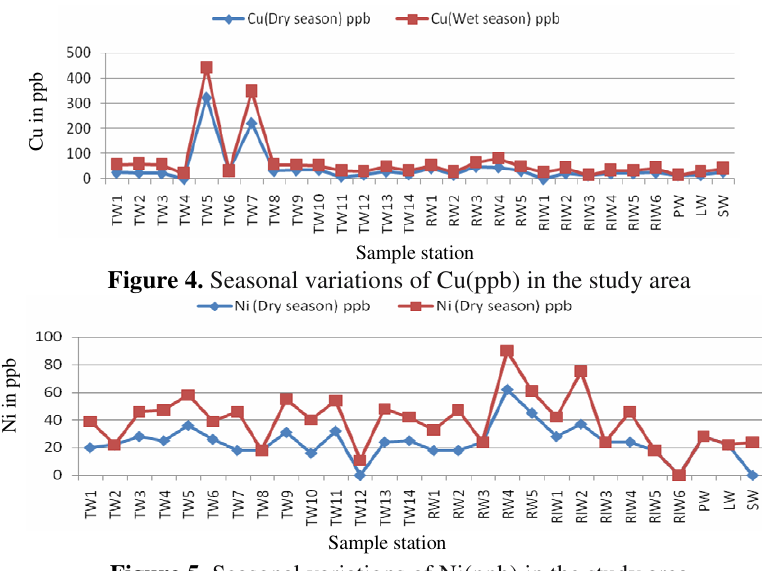
Figure 5. Seasonal variations of Ni(ppb) in the study area